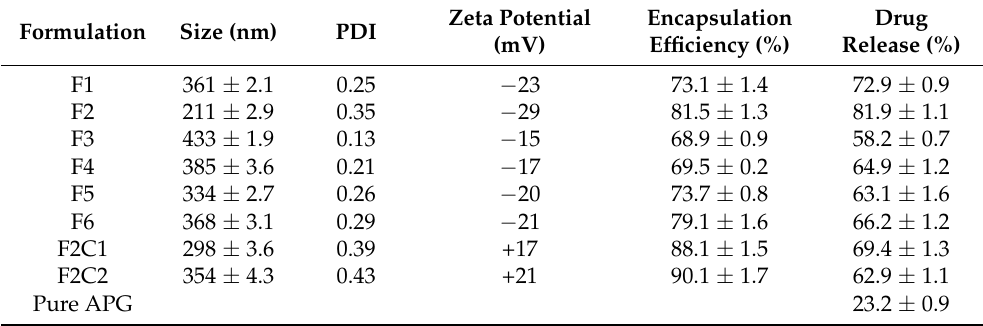
Table 2. Physicochemical data of apigenin bilosomes (APG-BLs) and chitosan-coated apigenin bilosomes (APG-CHBLs).